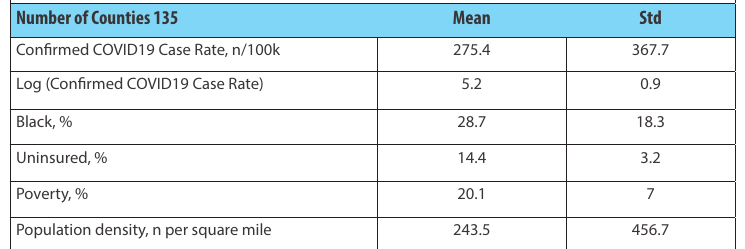
Table 1: Confirmed COVID-19 case rate and sociodemographic